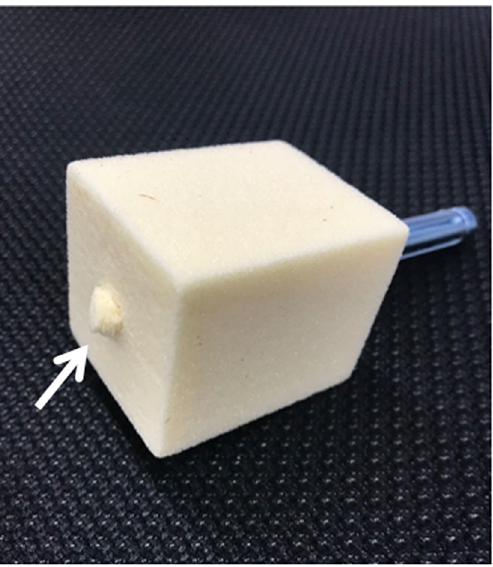
Figure 6. Protrusion of the nail on the surface of the polyurethane foam block following the push-in test (white